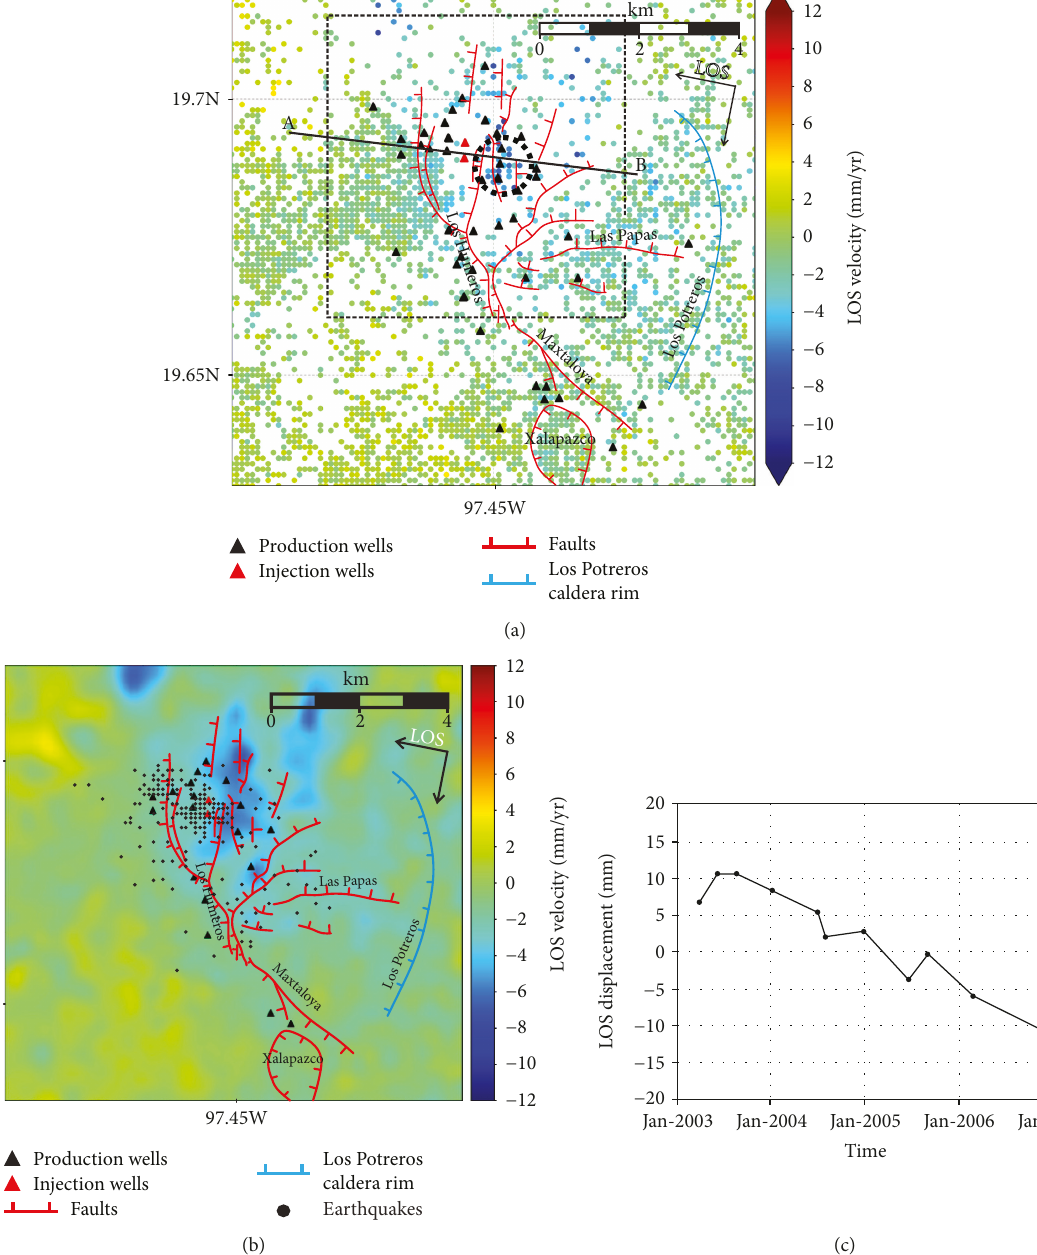
Figure 6: Mean (a) and interpolated (b) PS velocities in the LOS direction at the LHGF. Negative LOS velocities indicate movement away from the satellite ( ~ subsidence) and positive values indicate movement towards the satellite ( ~ uplift). The main structures after Norini et al. [11] and Carrasco-Núñez et al. [12] and the wells operating during the period of the InSAR are shown in both fi gures. The black dashed rectangle marks the outline of the area selected for modeling. The epicenters of induced earthquakes between December 1997 and October 2008 after Urban and Lermo [18] are plotted in (b). The time series of the mean LOS velocities from the area where the largest subsidence is observed (highlighted in (a) with dotted circle) is shown in